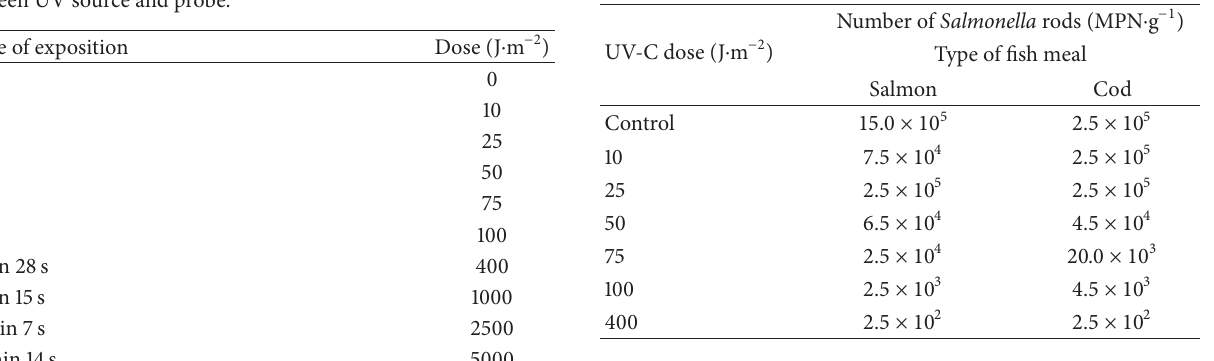
Table 2: Changes in the number of Salmonella depending on the surface density of the UV-C radiation dose.